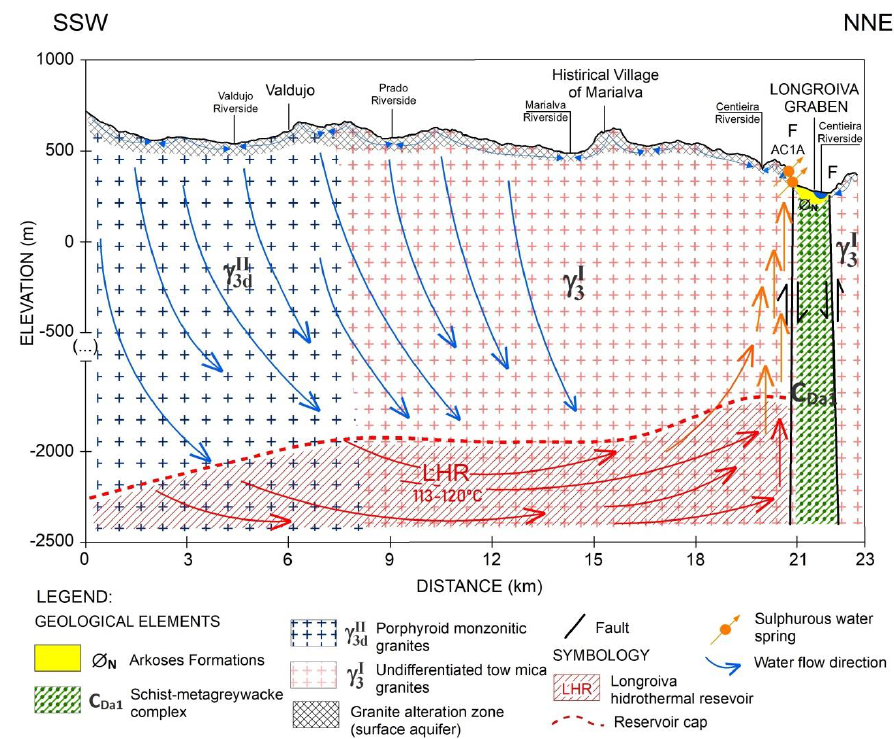
Figure 6. Conceptual model of the hydrothermal reservoir of the Longroiva Spa site based mostly on the interpretation of published geological and geochemical data (from Ferreira Gomes). Reproduced with permission from [48]. National Library Board Singapore, 2018.